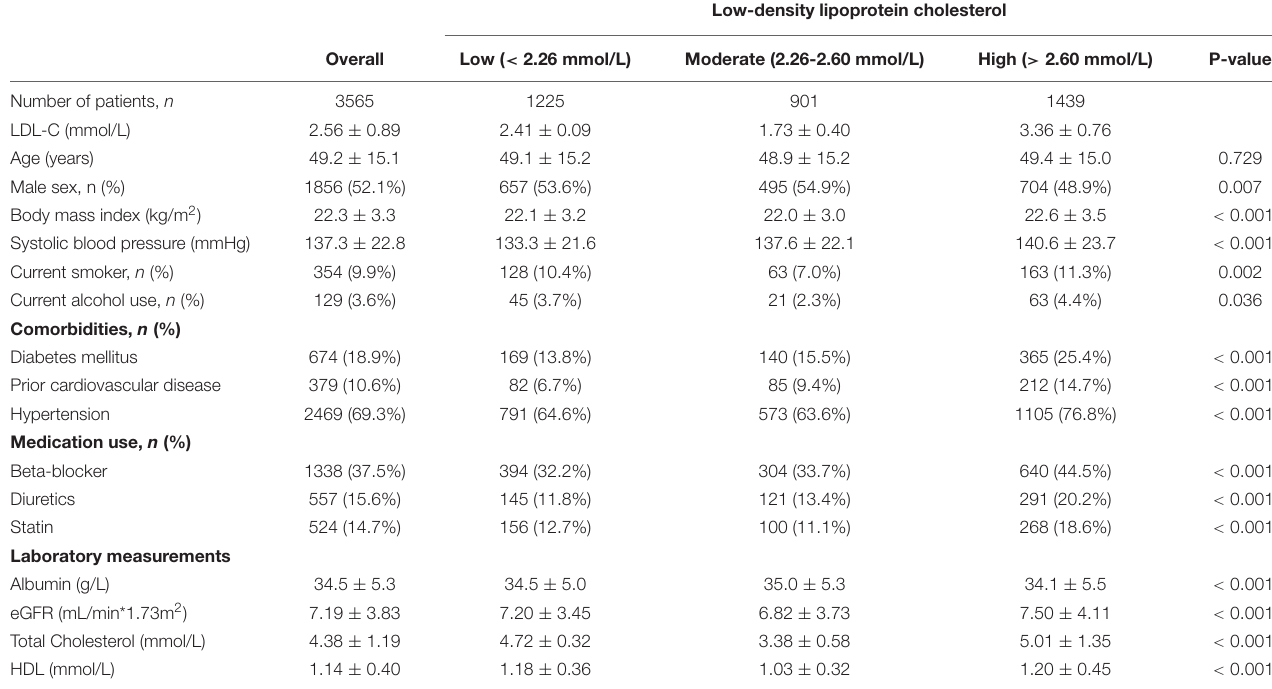
TABLE 1 | Baseline patient characteristics by categories of low-density lipoprotein